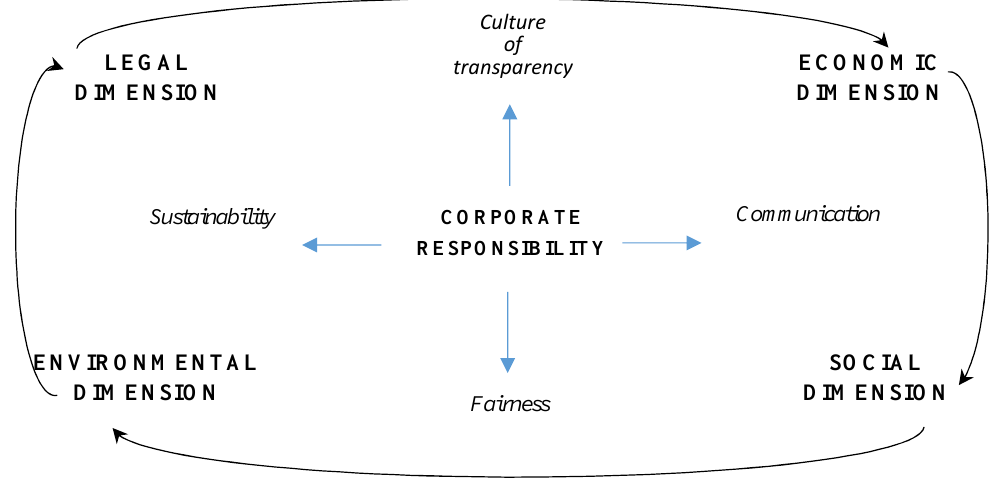
Figure 2: Corporate Responsibility and